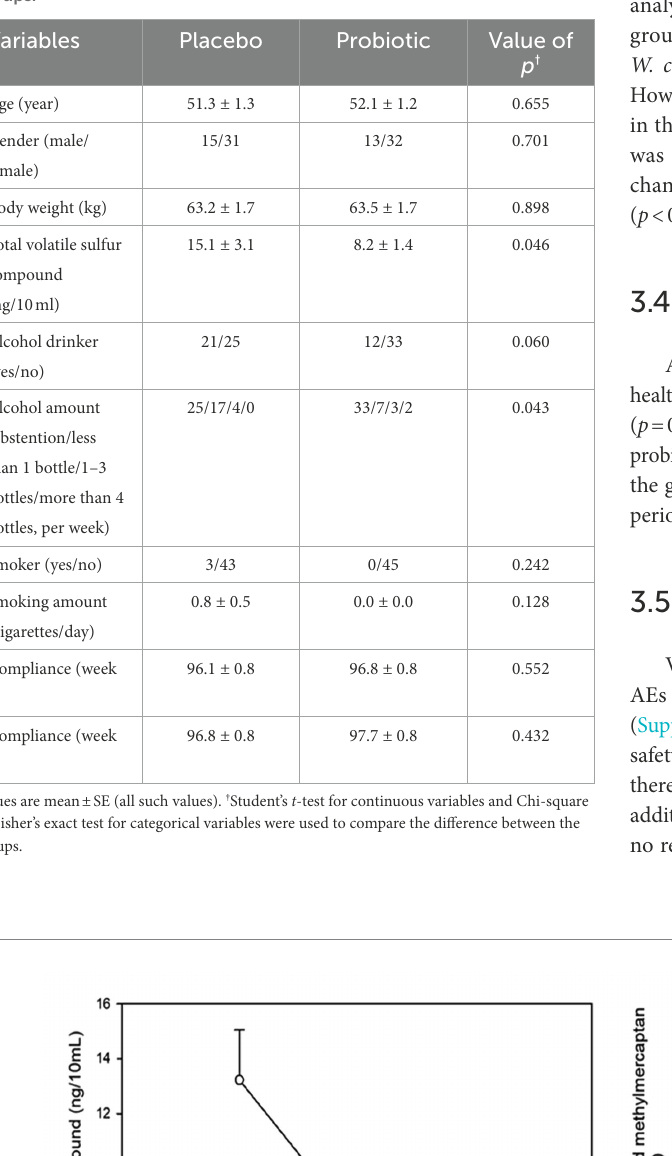
TABLE 1 Baseline characteristics of the subject in the placebo and probiotic groups.